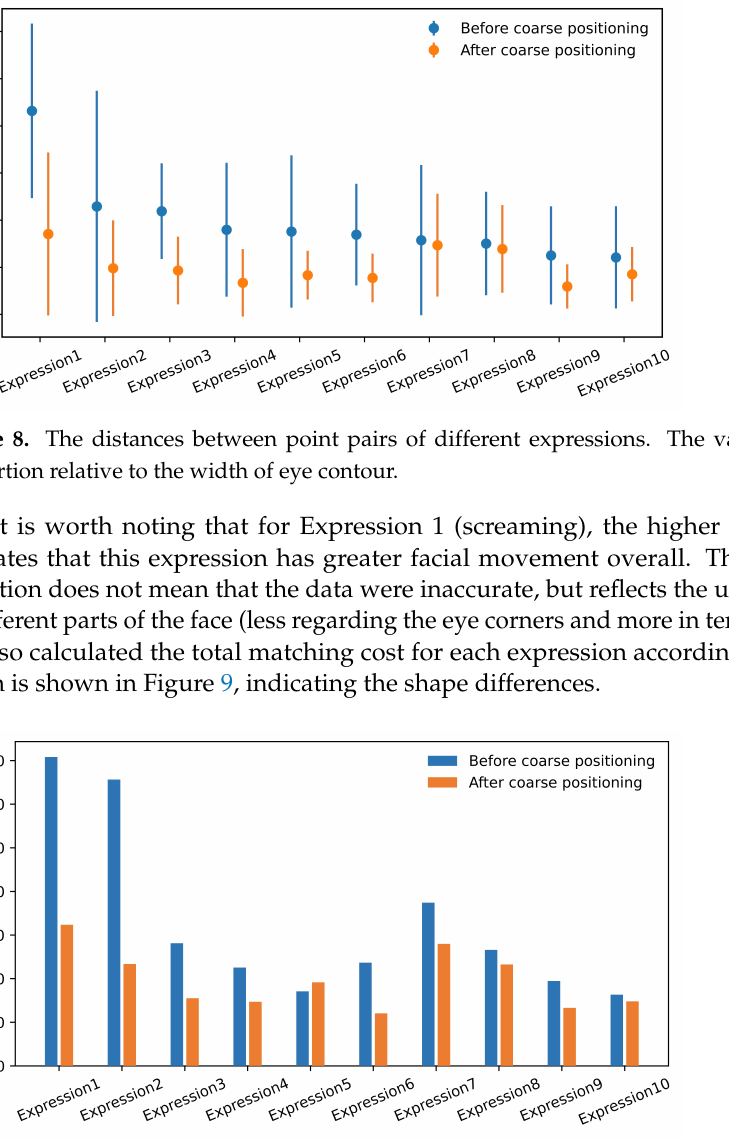
Figure 9. The matching cost for point sets of different